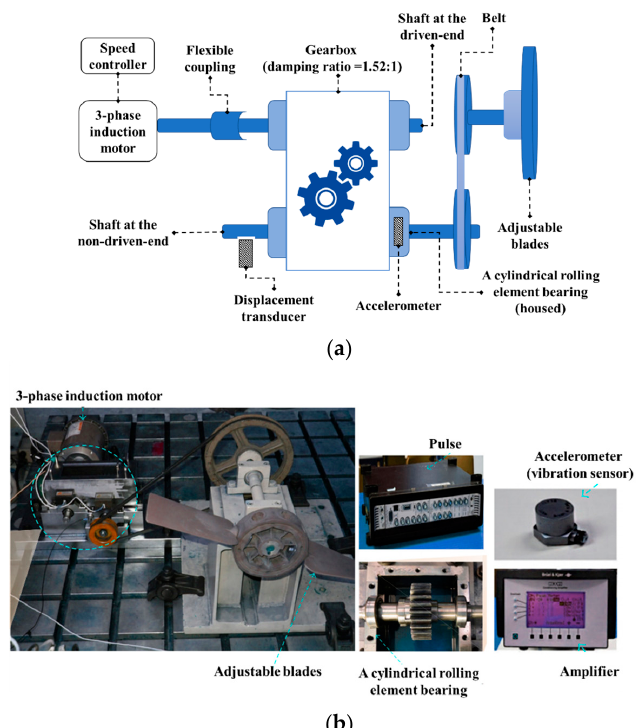
Figure 5. Testbed for collecting vibration signals from compound faults: ( a ) scheme of the experimental setup and ( b ) real experimental system. Table 2. Specification of the data acquisition system.